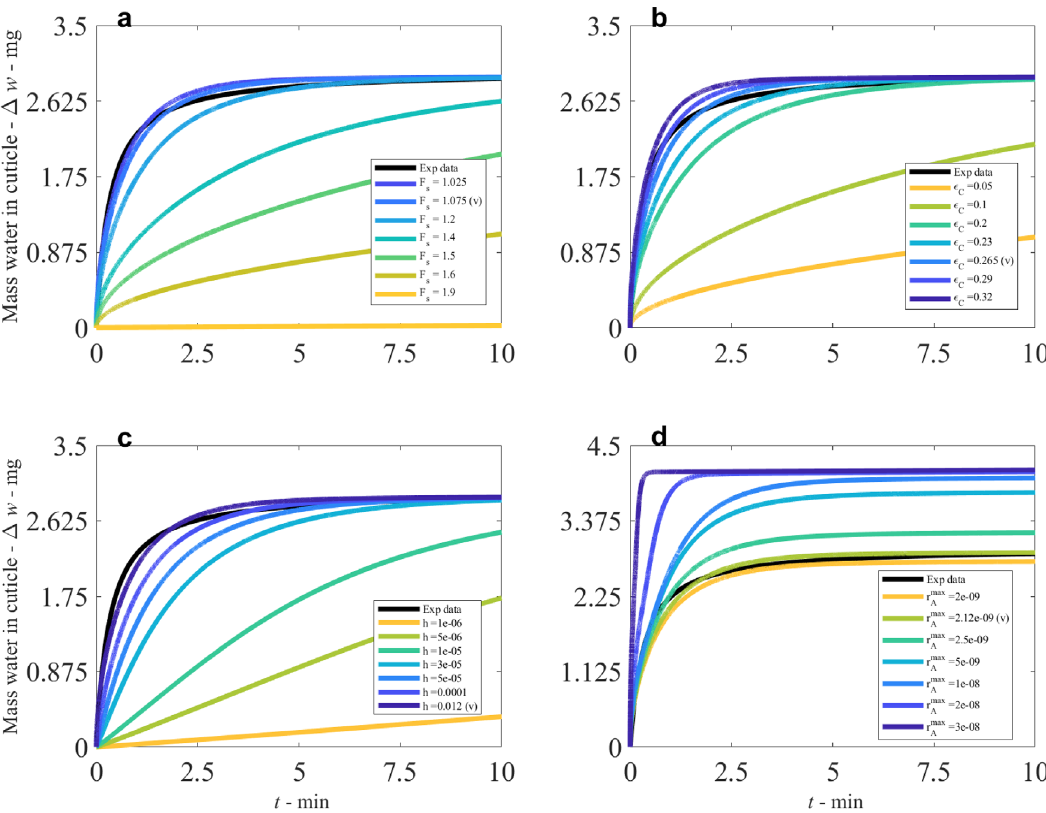
Fig. 4 Sensitivity analysis of the model, compared to the results for validation (v) and the experimental data (Exp data in black) as a reference point, all performed at 60%RH. All model parameters are kept constant except the sensitivity parameter. a shows the sensitivity of F s , the fractal scaling dimension, analogous to the tortuosity, b shows ε C , which is the porosity of cellulose, c shows h , the moisture transfer coef fi cient at the boundaries, and , the maximum radius of aqueous pores. Note for all the sub fi gures, the relationship is directly proportional, except for F s , which has an inverse d shows r max A